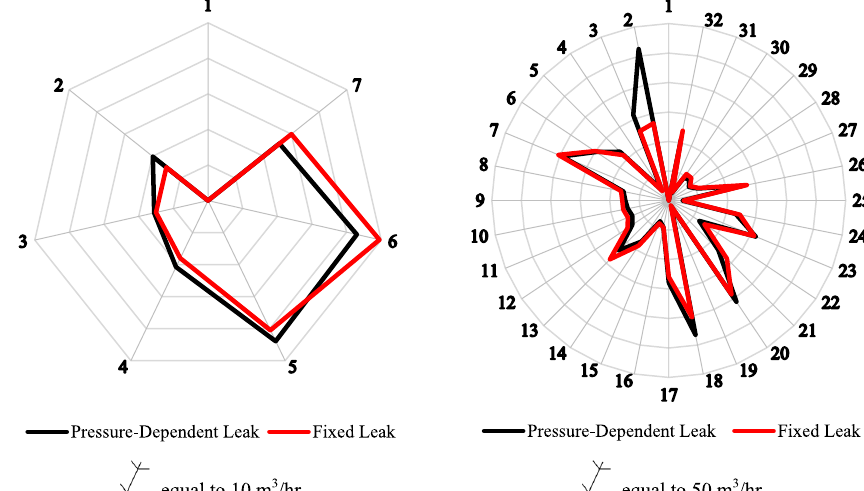
Fig. 11 Comparison of nodal leak discharge for fixed and pressure-dependent leakage: a. two-loop and b. three-loop